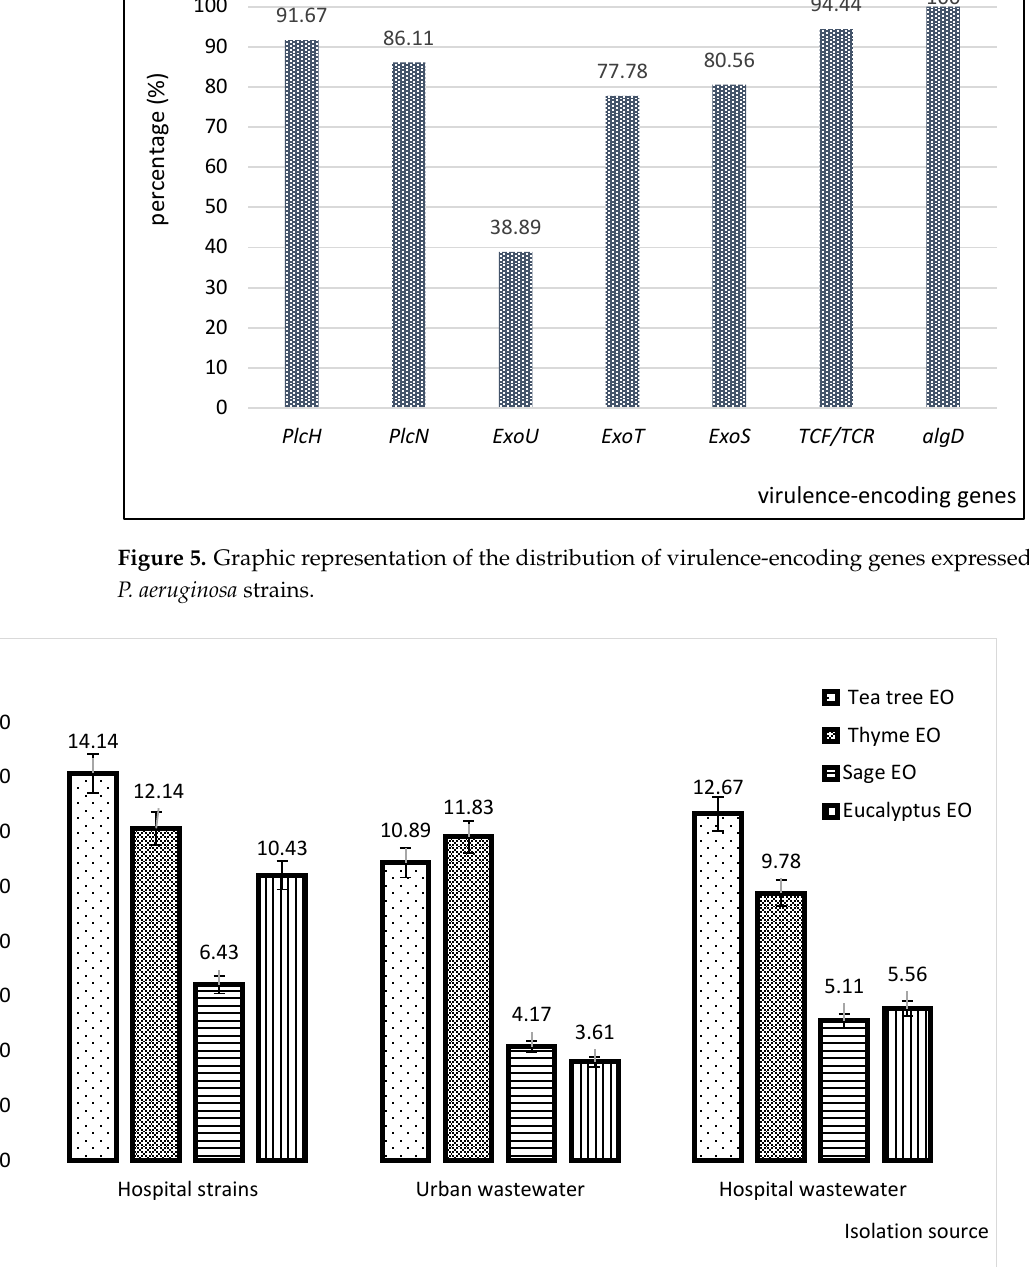
Figure 7. Average minimum inhibitory concentration (MIC) values, expressed as percent (%) con- centration of the EOs in P. aeruginosa strains, regardless of their isolation source. Next, we compared the minimum inhibitory concentrations of P. aeruginosa strains depending on the isolation source of the strains. The results in Figure 8 show that the mean value of the MICs for tea tree EO ranged from 0.538 to 0.759%; for thyme it was